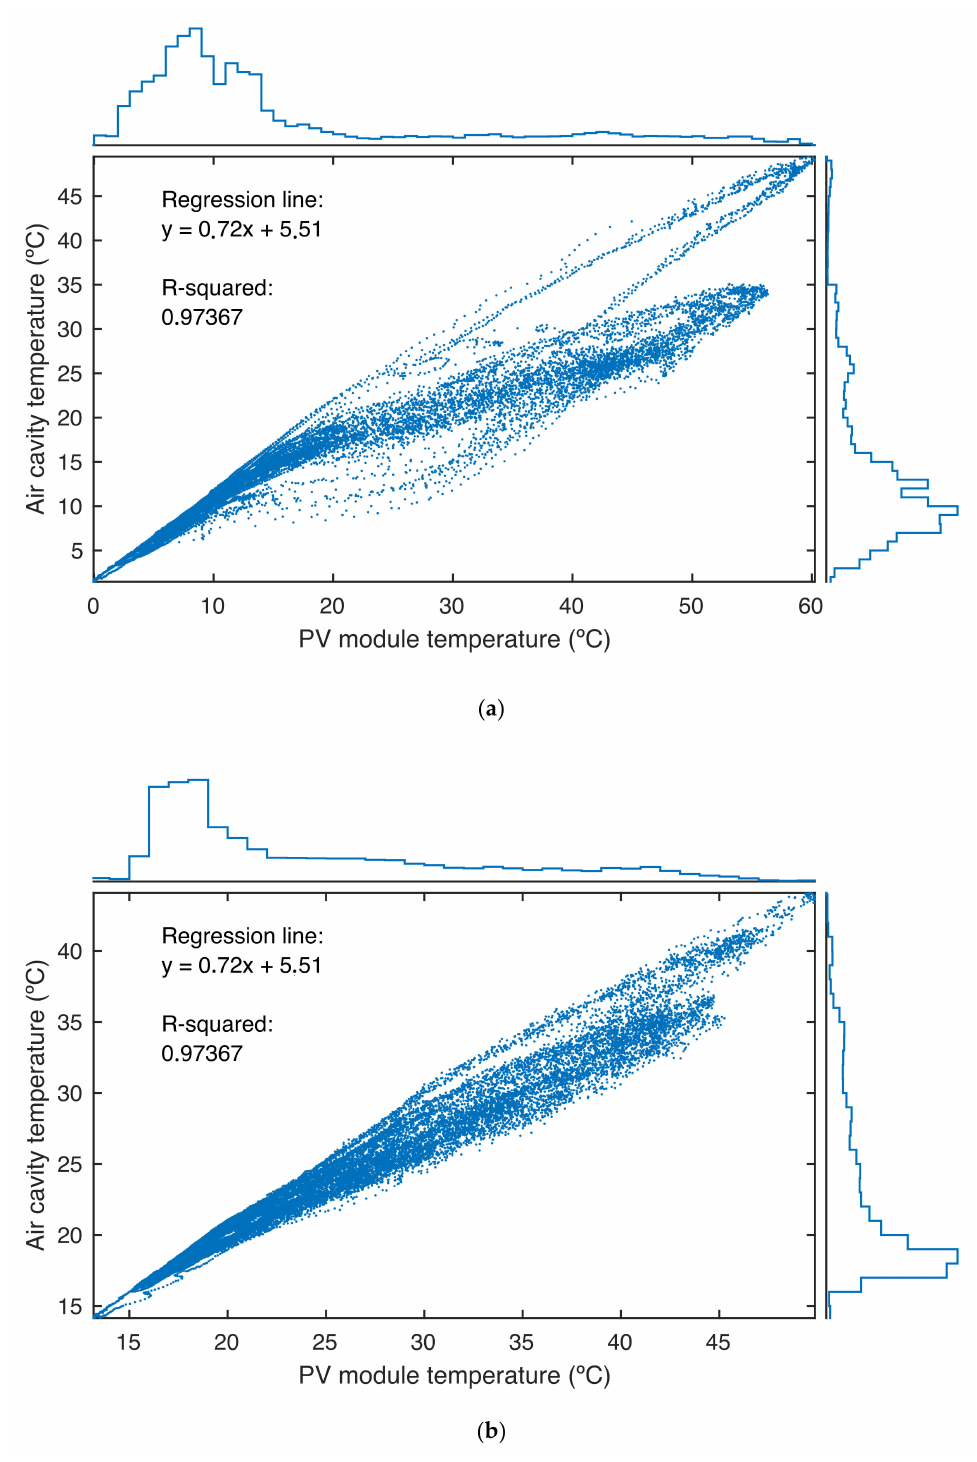
Figure 10. Relationship between air cavity and PV module temperature, with the histogram of the temperature bins of 1 ◦ C each bin, for ( a ) February/2018; ( b )